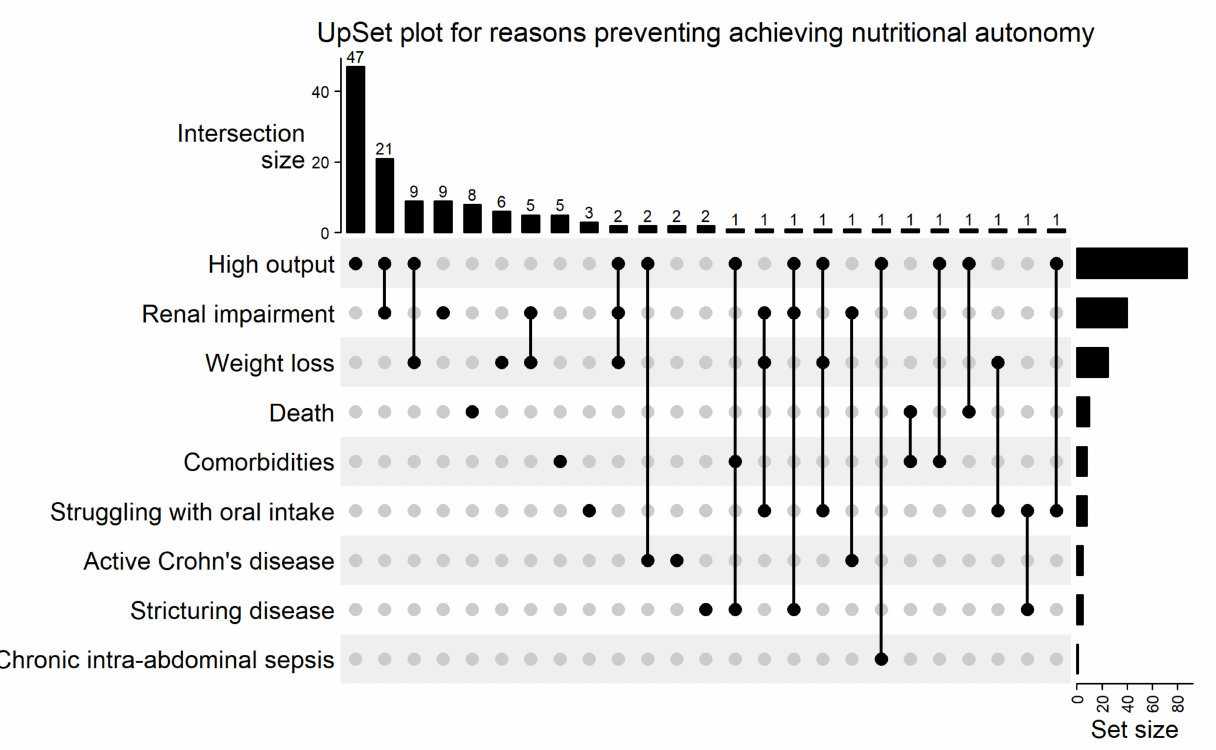
Figure 4. An UpSet plot to illustrate the distribution of reasons for not achieving nutritional autonomy in patients predicted to do so. The x-axis shows possible reason combinations. Each filled-in node shows an identified reason, with the vertical lines linking each reason within the combination. The frequency of each reason combination is shown along the y-axis, correlating to the number of patients with identified reasons as shown by the filled-in nodes. Set size represents the overall frequency of each